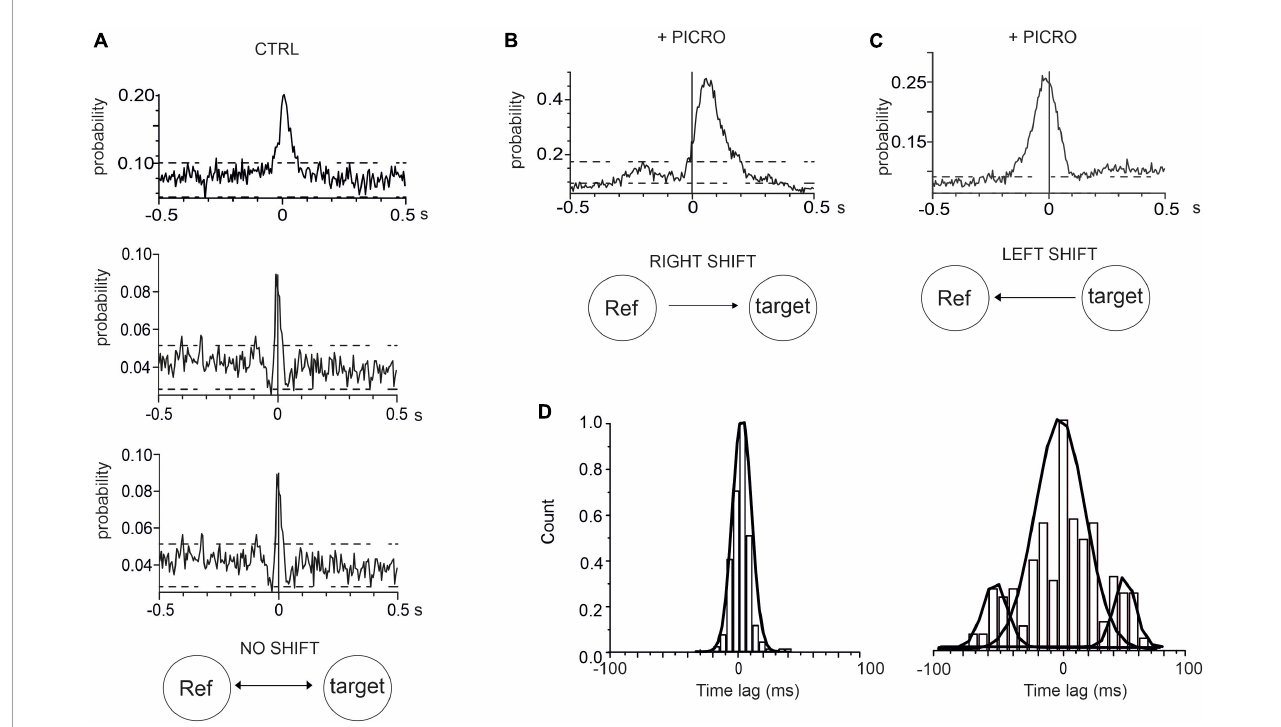
FIGURE5 Cross-correlograms histograms (CCH) in control and in the presence of picrotoxin. (A) Three representative CCH under control conditions, whose peak is centered around 0 ms. (B,C) Representative CCH with picrotoxin: in this case the CCH peak is shifted from 0 ms (see text for details). (D) Time-lag distributions of CCH peak for controls (left) and with picrotoxin